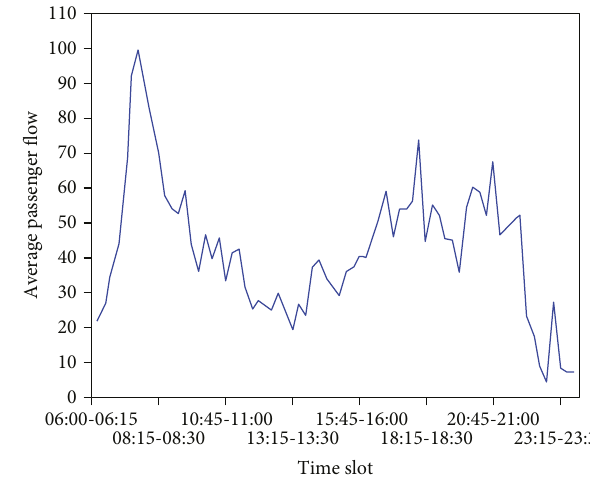
Figure 4: Line passenger fl ow curve per bus (July 1 – 15).